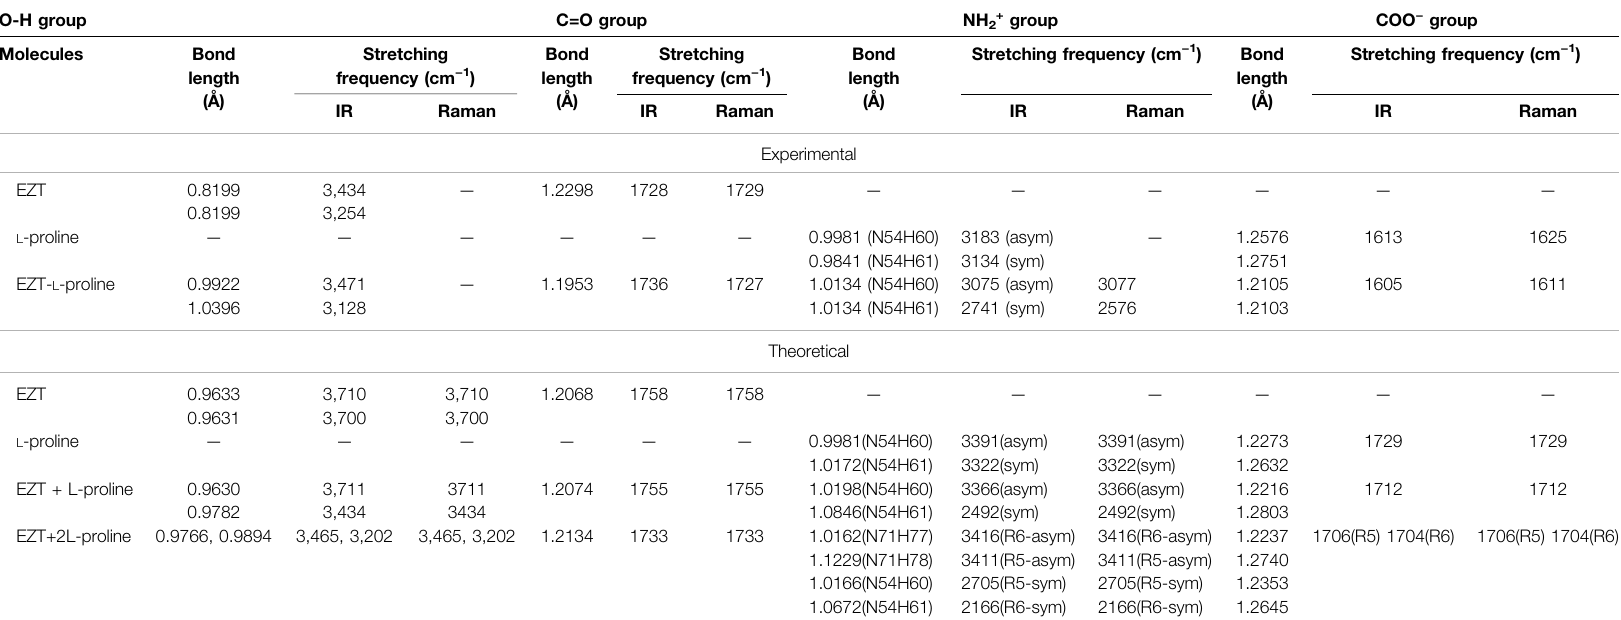
TABLE 1 | Comparison of experimental and theoretical stretching frequency (cm − 1 ) and bond length (Å) involved in hydrogen bonding. O-H